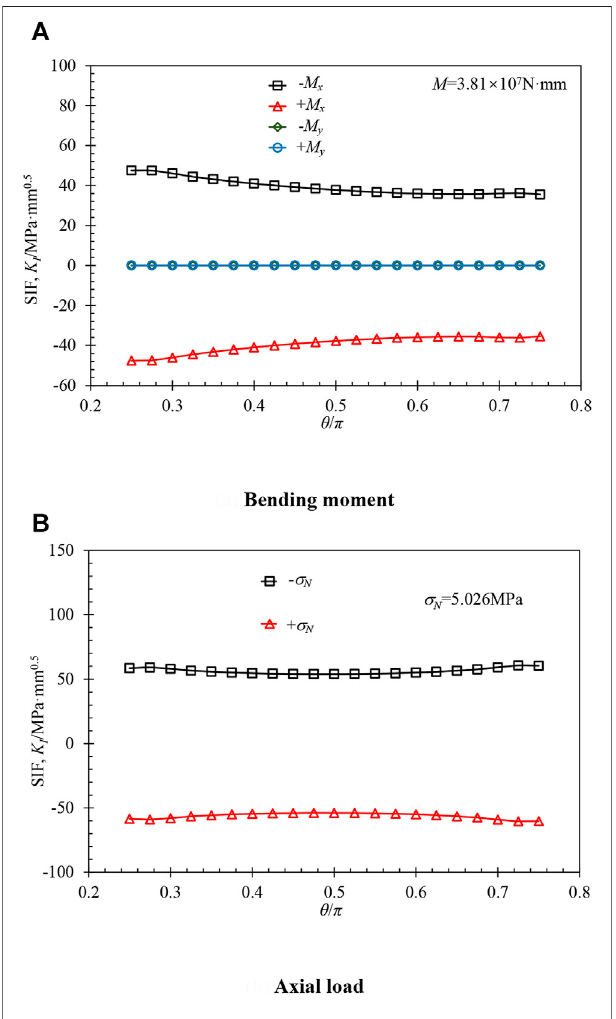
FIGURE7| Comparison oftheSIFs ofthe crackfront under axialloador bending moment at the end of nozzle in different directions ( φ (cid:1) 1, κ (cid:1) 0.141, R (cid:1) 0 mm).